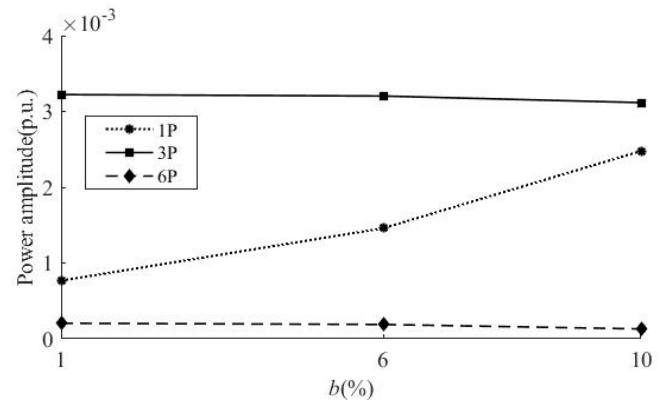
Figure 14. Amplitude of fault frequency for different degree of imbalance.